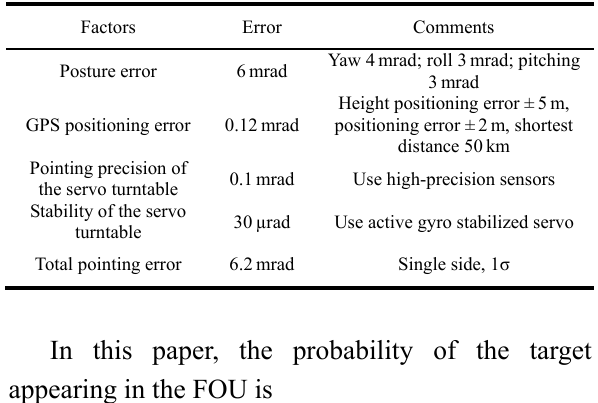
Table 3 Error Analysis of fine tracking.